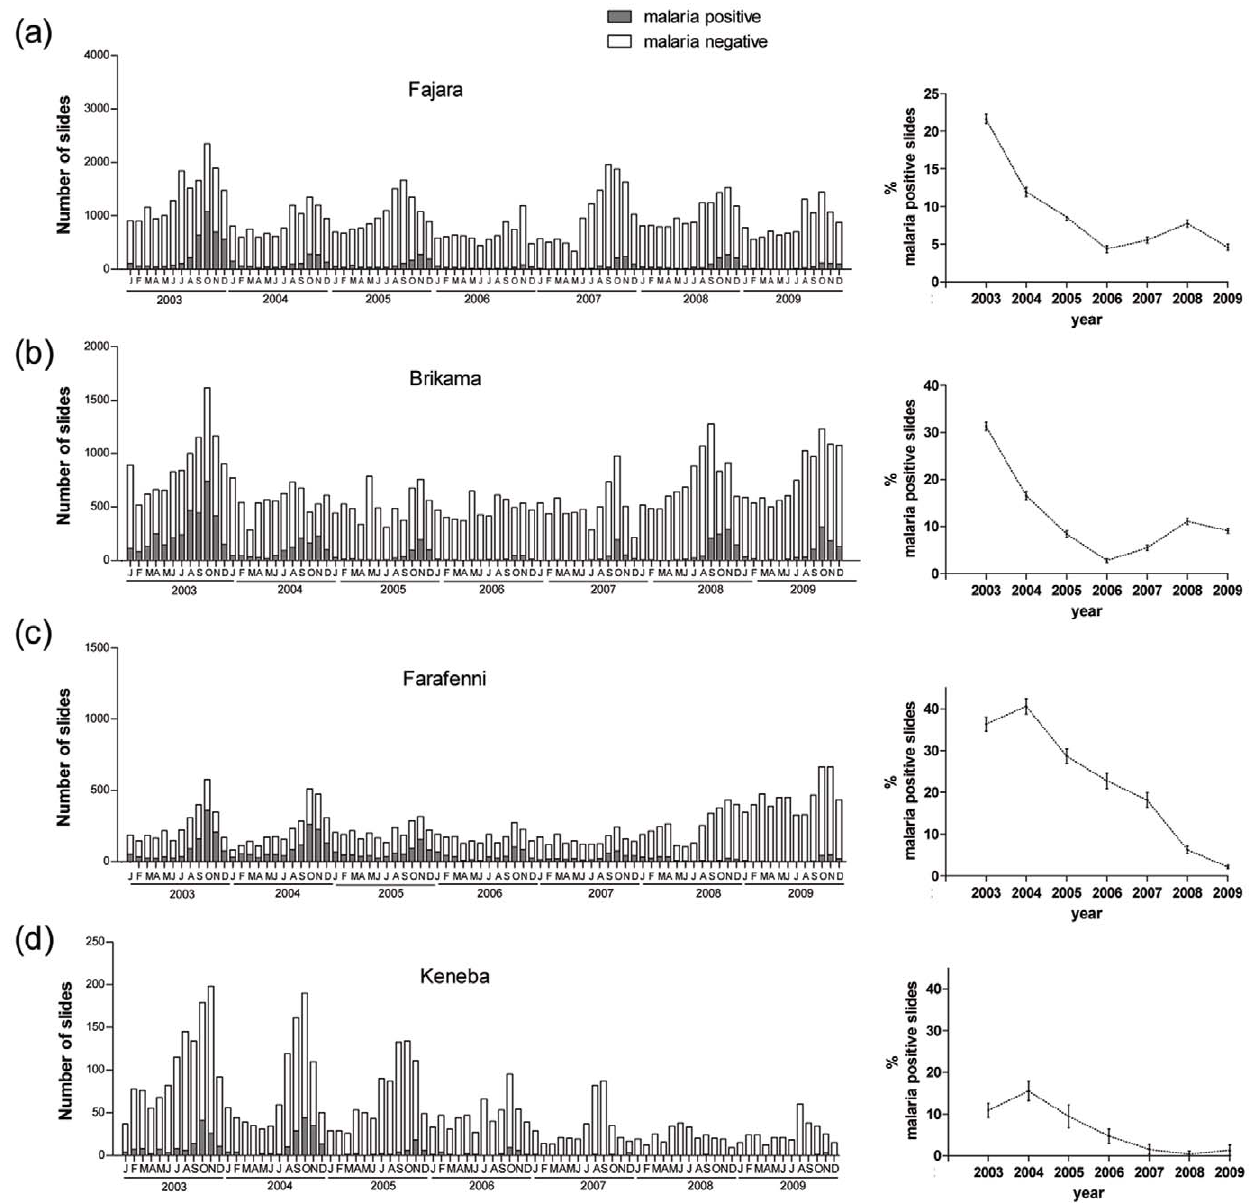
Figure 3. Malaria trends during 2003–2009 at 4 health facilities in The Gambia that had been previously surveyed until 2007. Monthly numbers (left panel) and annual proportions (right panel) of malaria positive slides from January 2003 to December 2009 at (a) Fajara MRC outpatient clinic, (b) Brikama Health Centre, (c) Farafenni AFPRC Hospital, and (d) Keneba MRC clinic.